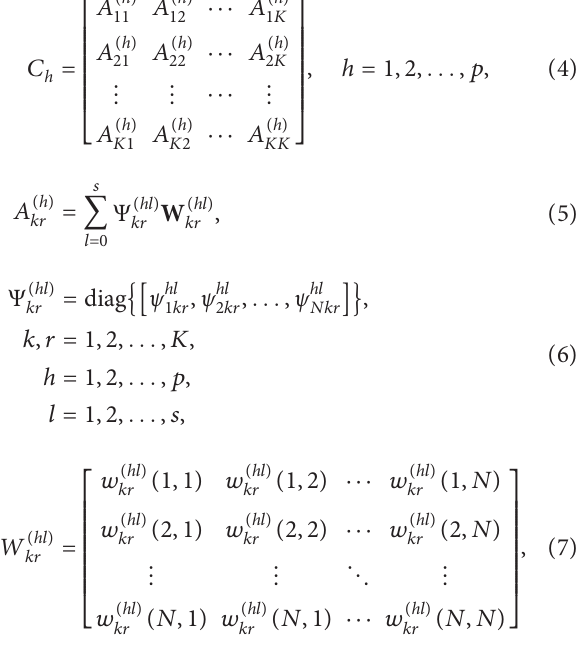
Figure 2: Studied